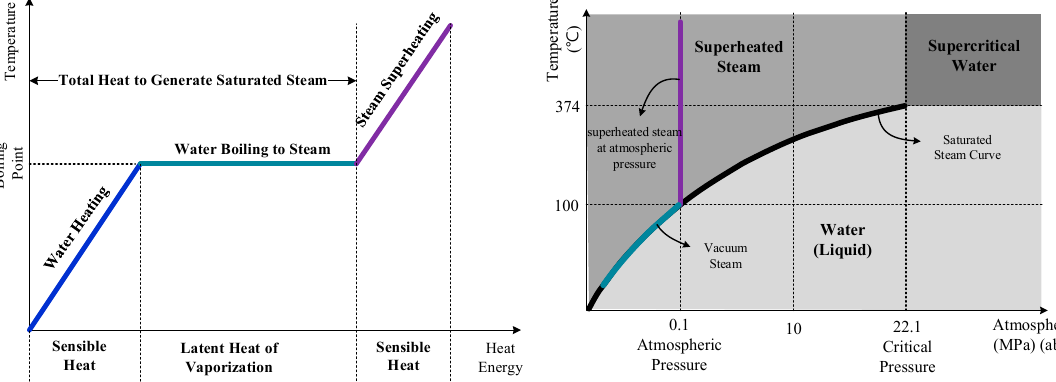
Figure 2. Temperature relationship of water and steam.